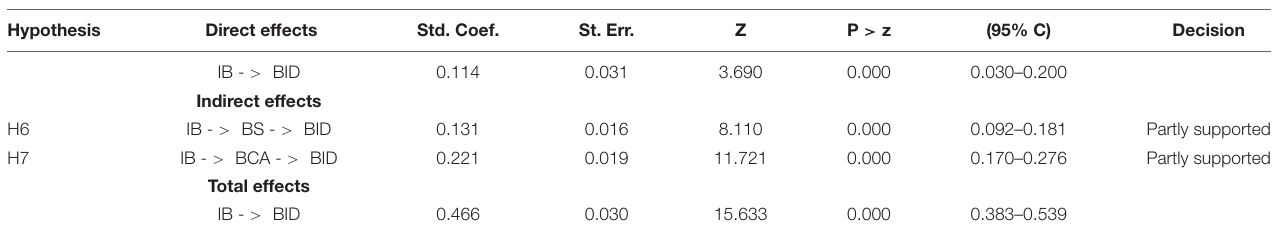
TABLE 6 | Tests of mediation (“Direct, indirect, and total effects, PLSc outputs”).